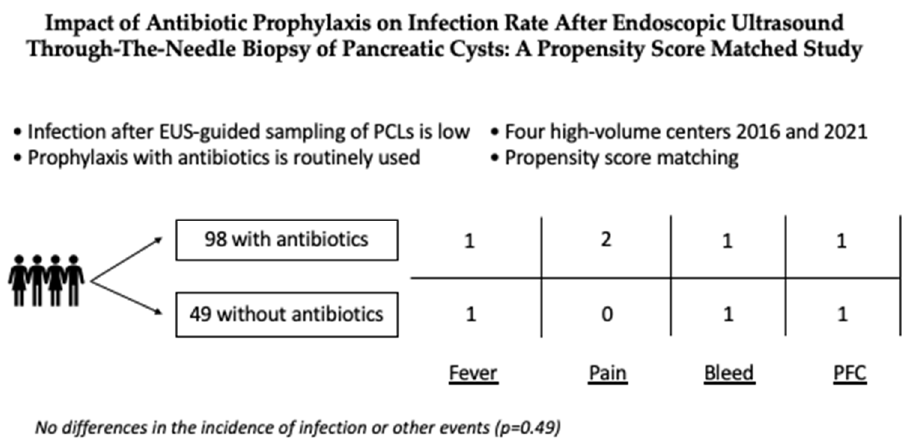
Figure 1. Pictorial description of the design of the study. PFC, pancreatic fluid collection. Baseline characteristics of the two matched sample groups are reported in Table 1, and details of the propensity score matching are depicted in Figure